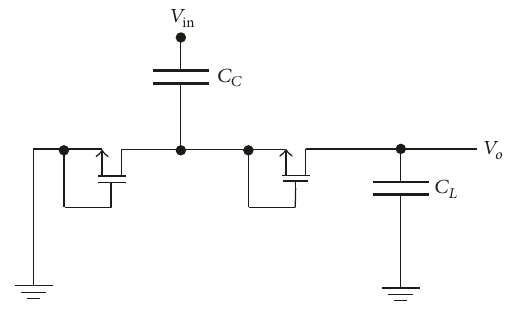
Figure 3: Simple diode-connected voltage doubler.